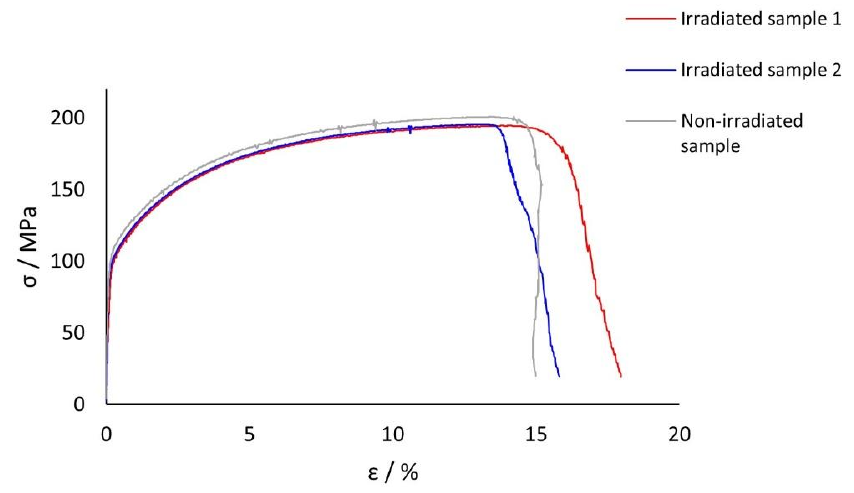
Figure 6. Stress-Strain curves of Al-B 4 C FSAP MMC. Table 8. Summary of tensile testing.